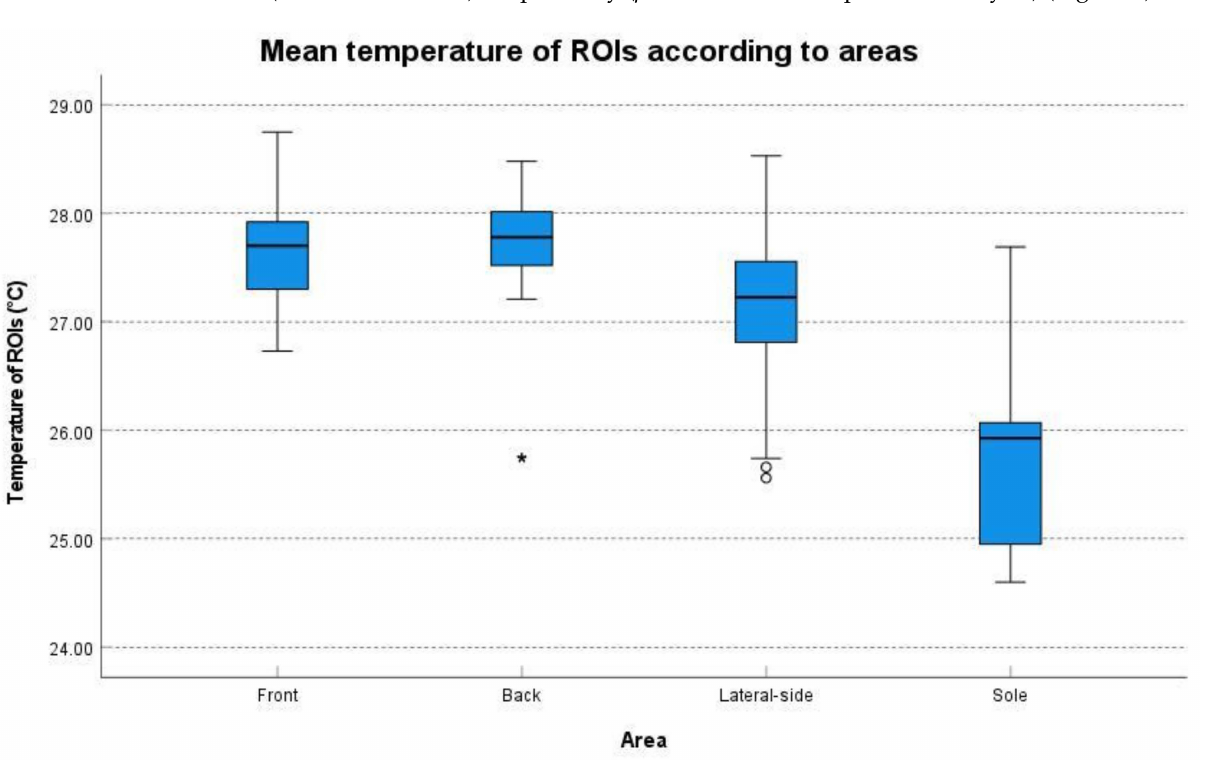
Figure 2. Diagram of the mean temperature according to the four areas. ROIs: region of interests; and * and ◦ are labels that are out of